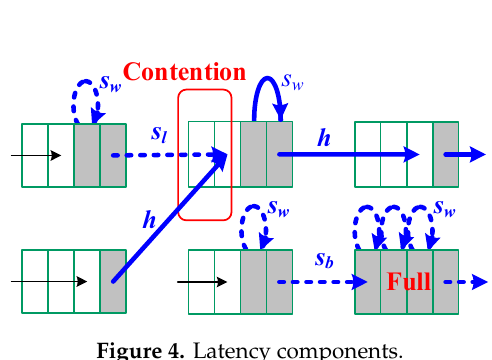
Figure 4. Latency components. Figure 4. Latency